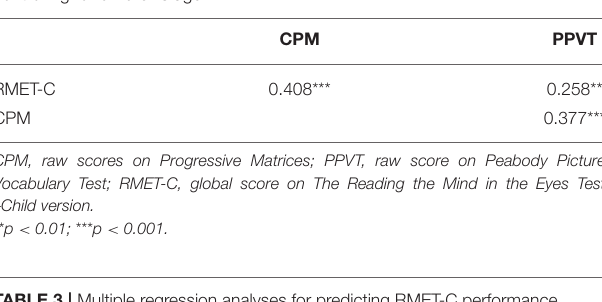
TABLE 3 | Multiple regression analyses for predicting RMET-C performance.